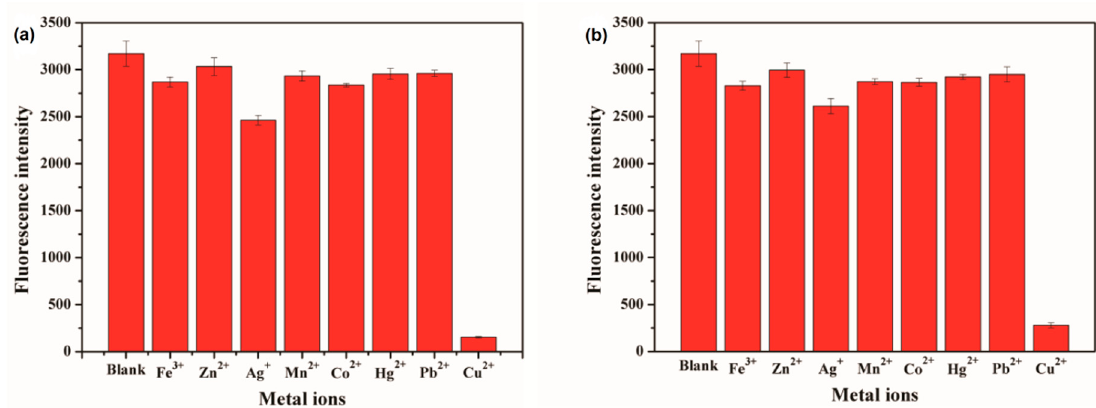
Figure 4. Fluorescence quenching efficiency of QDs in a solution with various metal ions. ( a ) The concentration of metal ions is 5 µ M. ( b ) The concentration of metal ions is 10 µ M. Table 3. The concentrations of copper ion in the